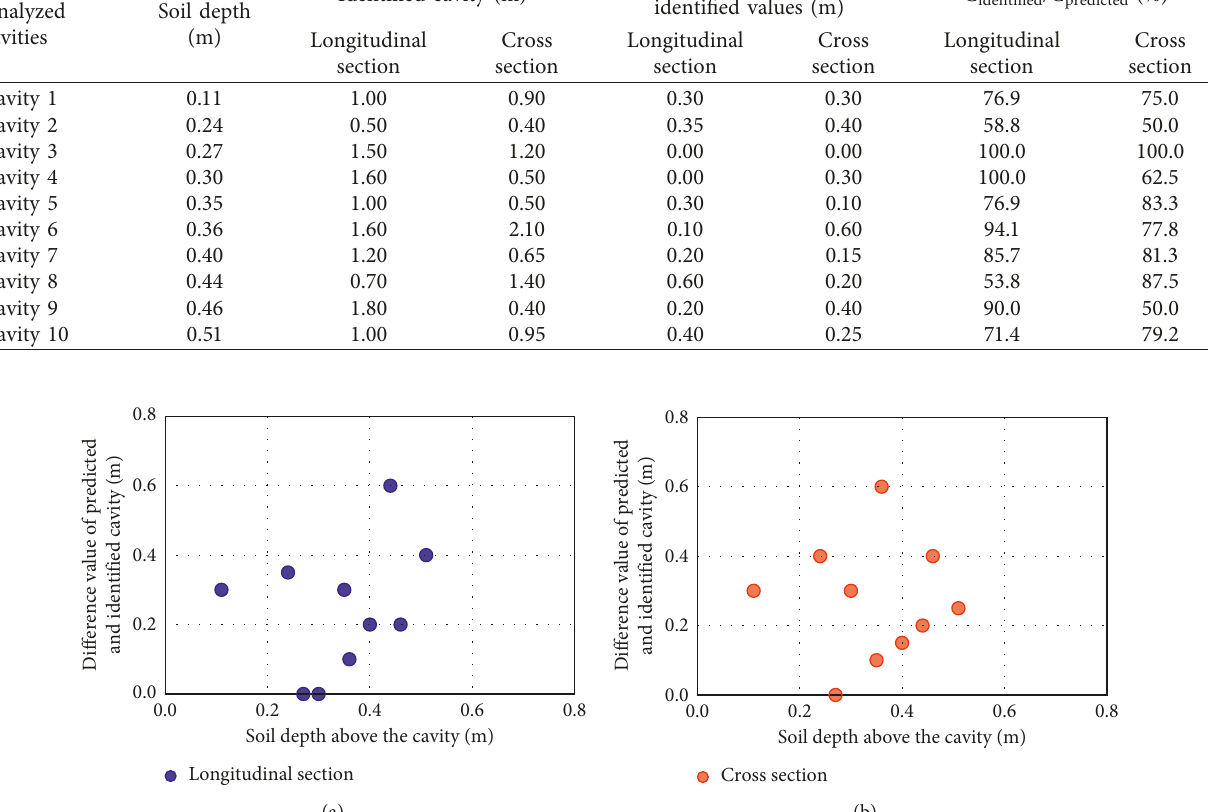
Table 4: Calculation results of the difference in scales between the predicted cavity and the identified cavity according to the soil depth. Analyzed